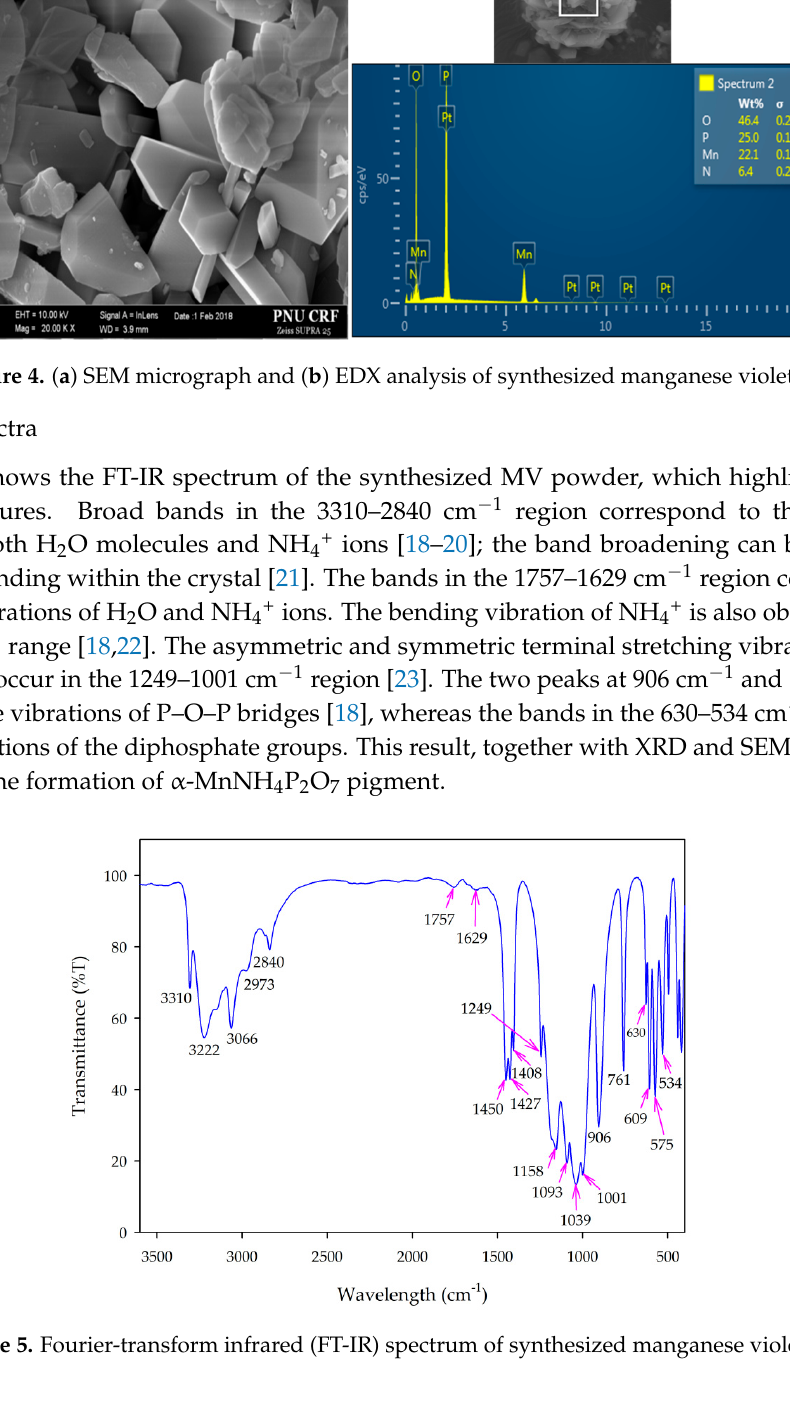
Figure 5. Fourier-transform infrared (FT-IR) spectrum of synthesized manganese violet.